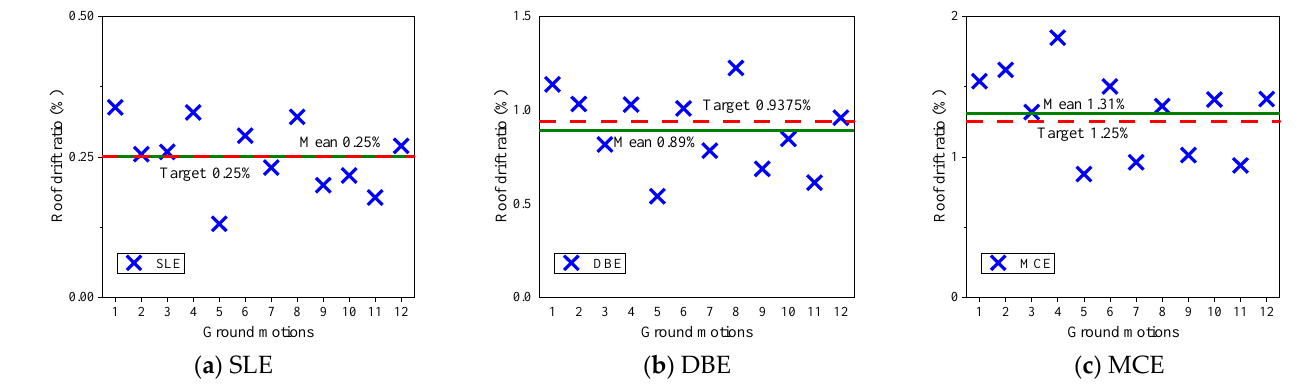
Figure 18. Comparison of the analytical and designed roof drift ratios. Figure 19 compares the roof drift time history curves of the prototype and the enhanced SMRF, taking the responses of earthquakes GM4 (with the maximum response) and GM5 (with the minimum response) as an example. Under the excitation of GM4, the peak roof drifts are reduced by enhancing from 228 mm, 574 mm and 867 mm to 122 mm, 383 mm and 687 mm, respectively, for SLE, DBE and MCE levels, while the residual drifts are reduced from 1.12 mm, 200 mm and 461 mm to 0.02 mm, 13 mm and 210 mm. Under the excitation of GM5, the peak roof drifts decrease from 115 mm, 336 mm and 594 mm to 49 mm, 201 mm and 326 mm, while the residual drifts decrease from 0.5 mm, 22.2 mm and 72.6 mm to 0 mm, 1.3 mm and 2.1 mm. These results show that the dynamic responses can be significantly mitigated by the presented PSCRSW. Moreover, the maximum residual inter-story drift ratios before and after enhancement are compared in Figure 20. As can be seen, the residual inter-story drift ratios are obviously decreased by enhancing overall. The mean degradation of all the earthquake records is about 54%, indicating that the structural recoverability post-earthquakes would be improved.